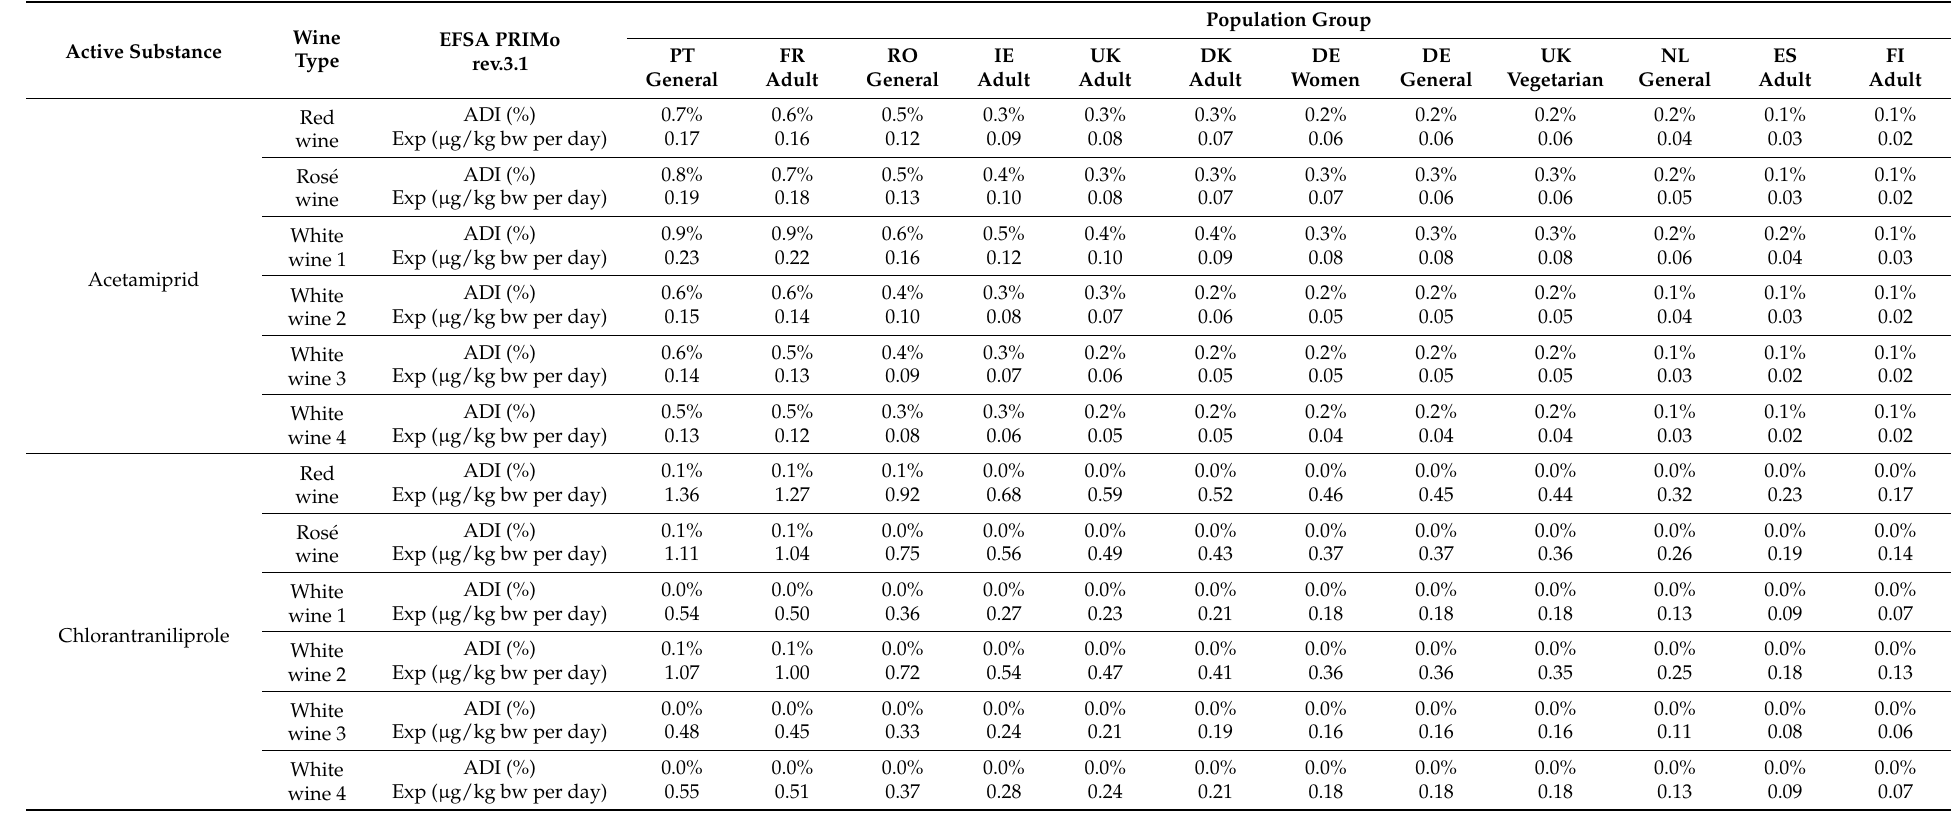
Table 6. The chronic (long-term) exposure of EU populations to pesticide residues from Romanian wines, expressed as the acceptable daily intake (ADI, in percent) and exposure (Exp, in µ g/kg bw per